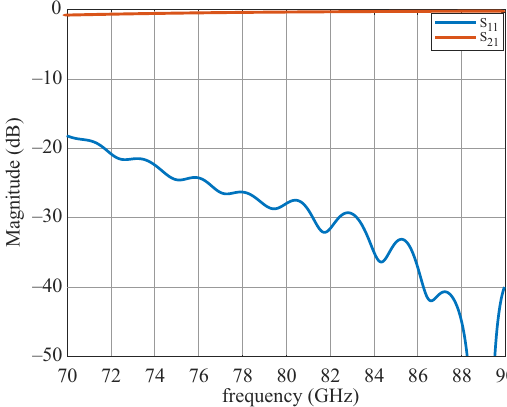
Figure 20. Simulation results of the corrugated